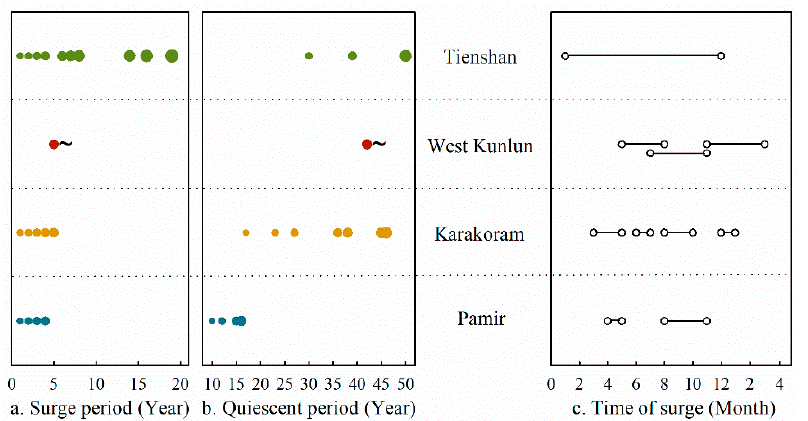
Figure 15. The surge phase ( a ), quiescent phase ( b ) and the time of surge ( c ) in different regions of High Asia ( ● ~—indicates a year greater than that (5, 42) indicated by the symbol. Data in the figure are from the literature ([11,16,21,56,84,88,89]; this study)).